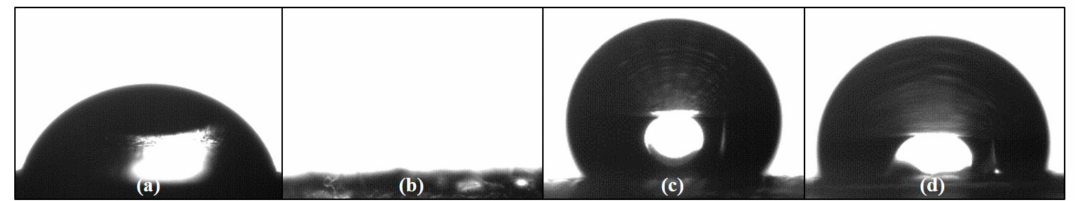
Figure 4. Optical images of water droplet on surfaces of ( a ) solid silver/silver chloride, as well as ( b ) cotton, ( c ) nylon, and ( d ) polyester